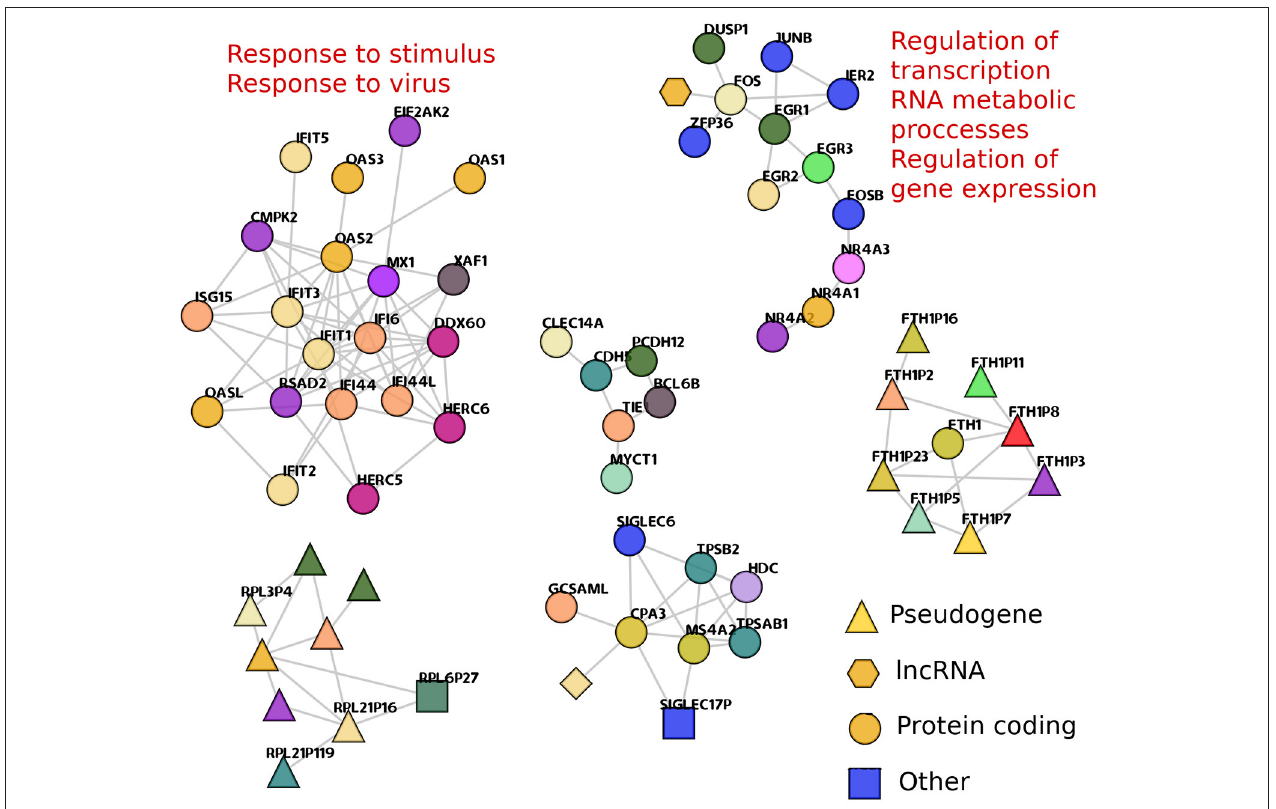
FIGURE 5 | Shared trans- components between TAD and TSC networks. trans- clusters that are found in both TAD and TSC are depicted. The shape of nodes represents the transcriptional species of the nodes. Enriched processes that are associated with a particular component are presented. The FTH1 component (bottom right) shows one only gene, that codifies for ferritin1, and all other nodes in the component are ferritin pseudogenes, showing that in this case, co-expression favor sequence similarities over gene physical closeness.